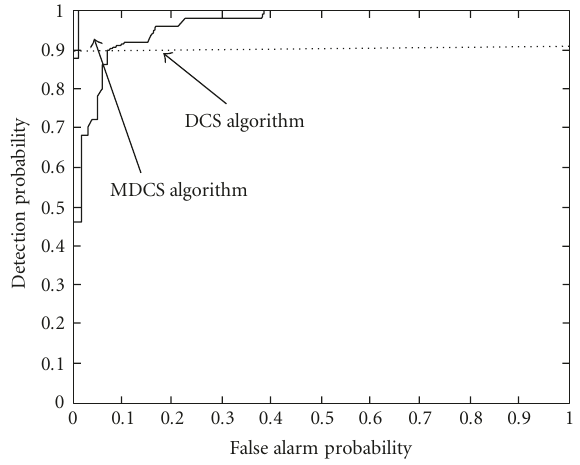
Figure 7: Comparison of DCS and MDCS methods by ROC curves computed from simulated data. x -axis: false alarm probability, y - axis: detection